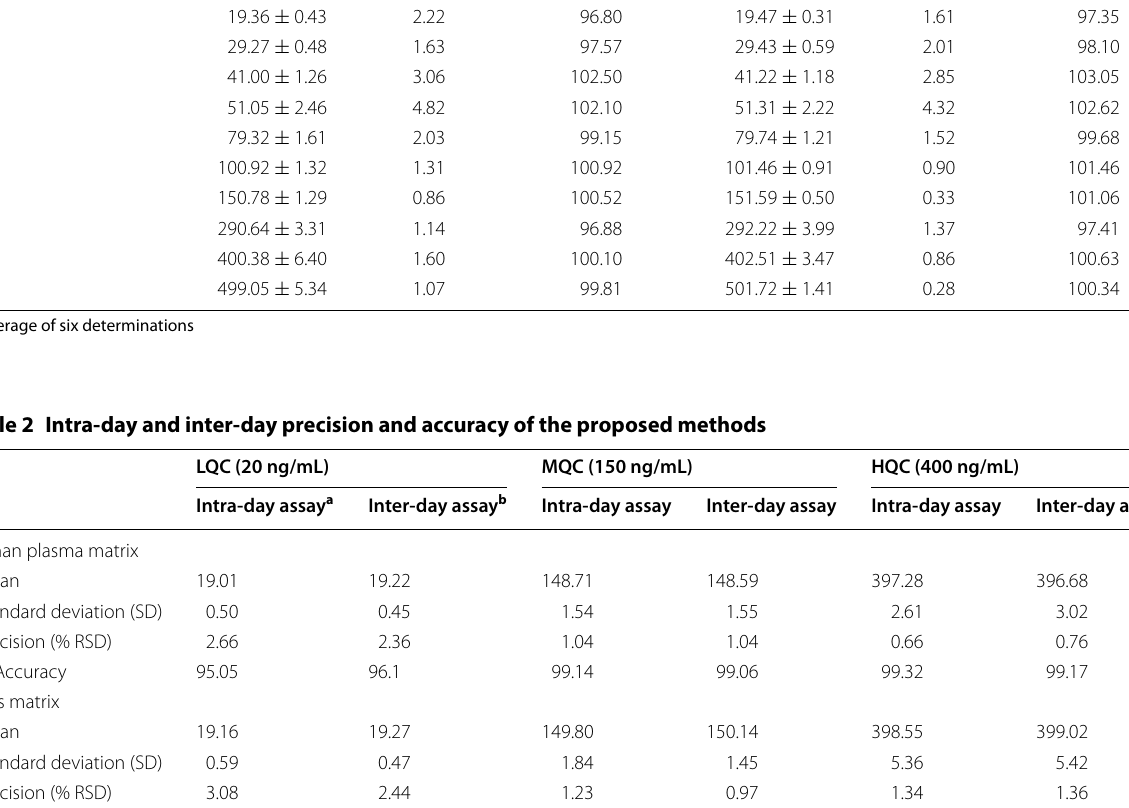
a Average of twelve determinations of day 1 b